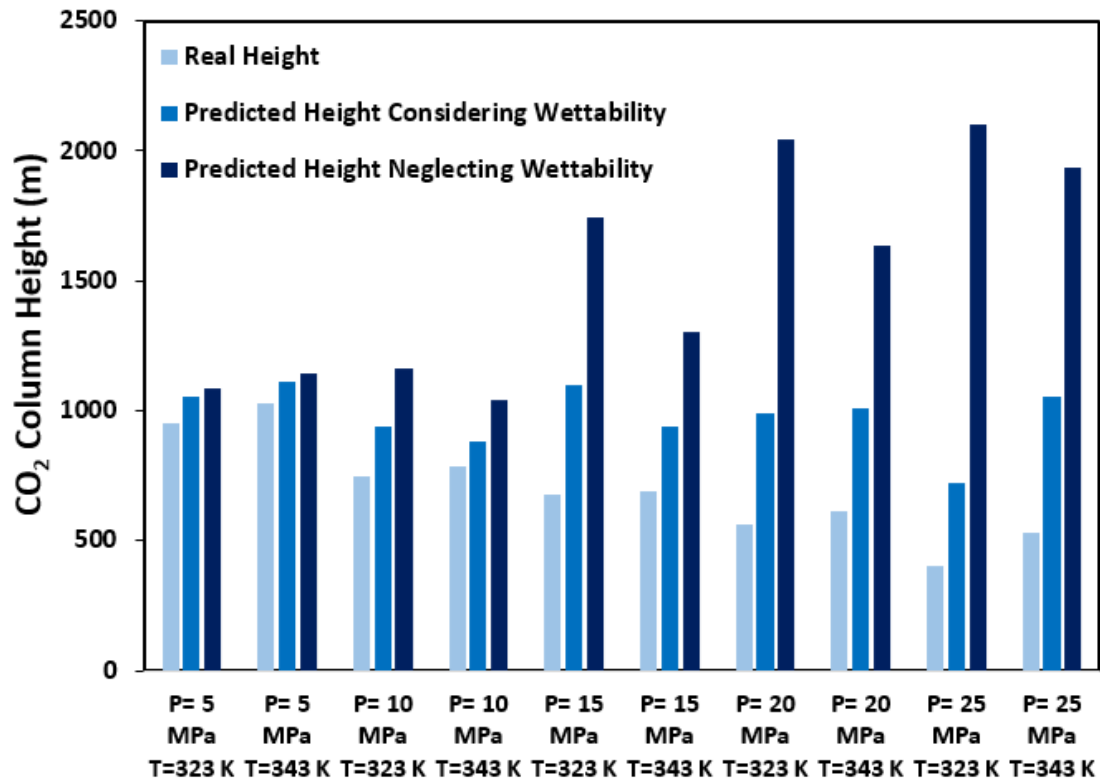
Figure 14. Comparison between CO 2 column height values of the considered cases.